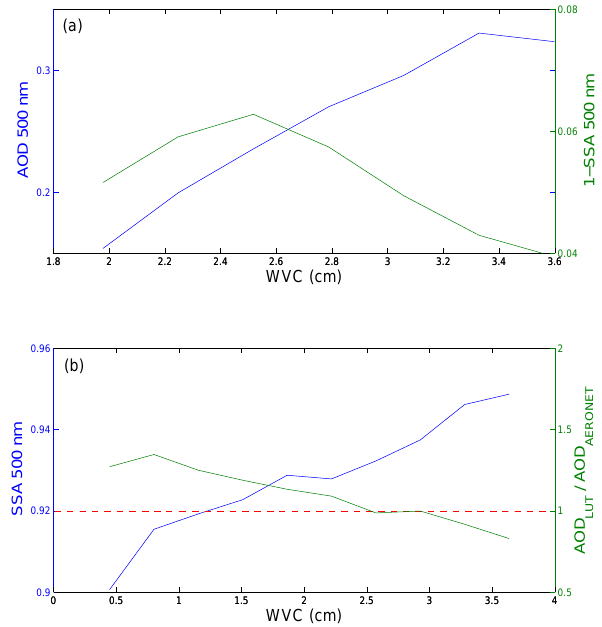
Figure 6. (a) Aerosol optical depth (AOD), water vapour content (WVC) and 1-SSA at 500nm from the AERONET inversion sky data. (b) SSA at 500nm, WVC and the LUT’s predicted AOD di- vided with the observational AOD (AERONET), with the red line fixed to SSA (500nm) = 0.92 (as in